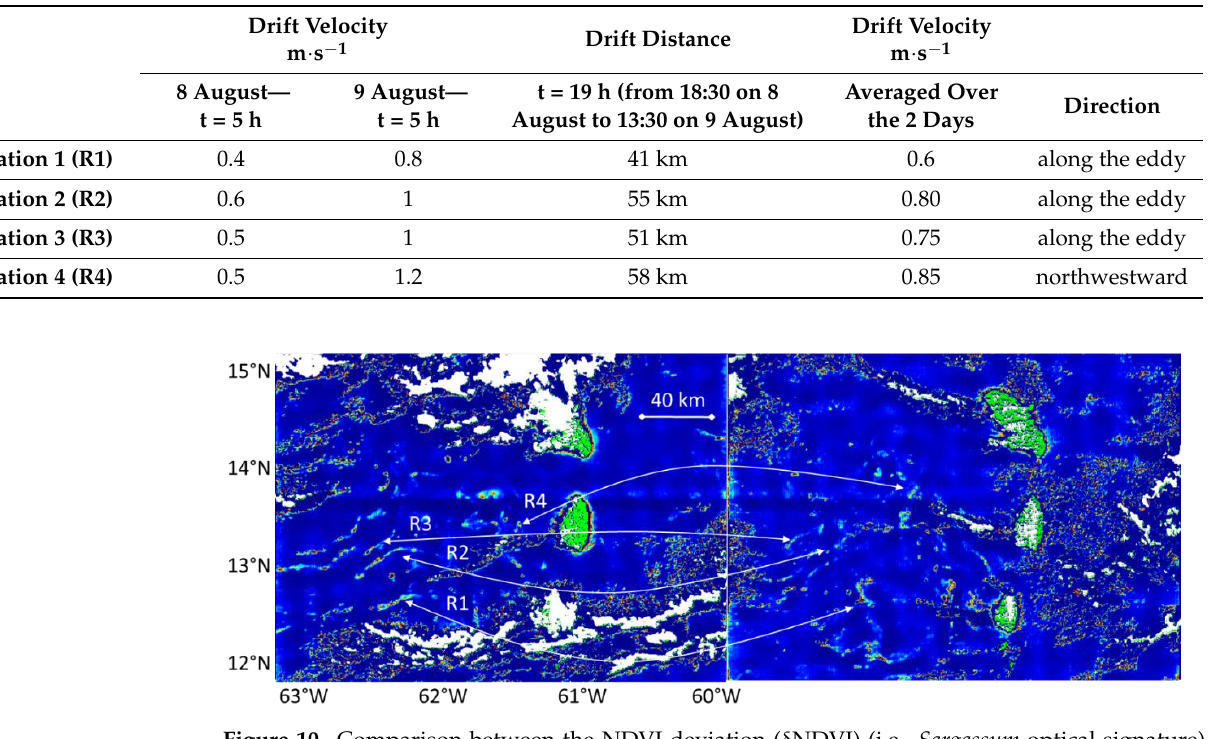
Figure 10. Comparison between the NDVI deviation ( δ NDVI) (i.e., Sargassum optical signature) measured from GOES data on 8 August 2018 at 16:30 UTC ( left panel ) with a similar observation made 24 h after, on 9 August 2018 at 16:30 UTC ( right panel ). The white arrows link four identified aggregations from one day to the other.